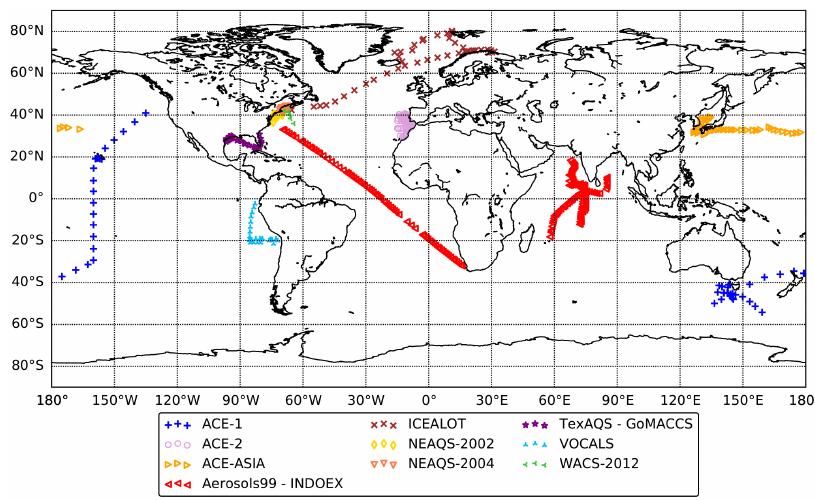
Figure 2. Map showing the locations of the nss-SO 2 − measurements used in the model assessment. All cruise data were obtained from the 4 NOAA PMEL Atmospheric Chemistry Data Server (http://saga.pmel.noaa.gov/data) collected by ACE-1 (October–December 1995), ACE-2 (June–July 1997), ACE-ASIA (March–April 2001), Aerosols99-INDOEX (January–March 1999), ICEALOT (March–April 2008), NEAQS (July–August 2002), NEAQS (July–August 2004), TexAQS-GoMACCS (July–September 2006), VOCALS (October–December 2008), and WACS (August